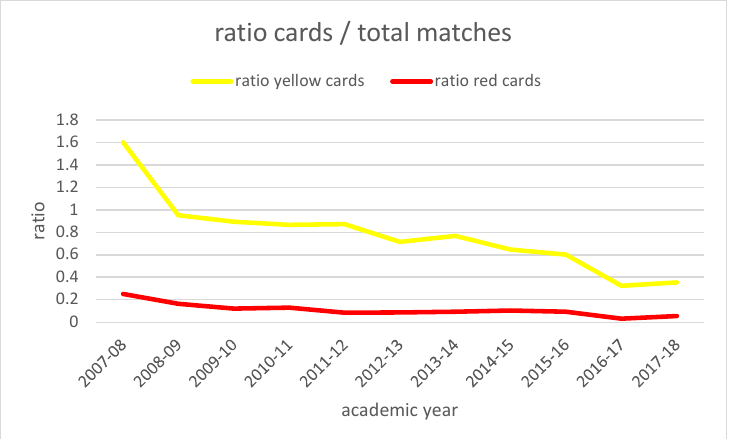
Figure 2. evolution of ratio of yellow cards and ratio of red cards through the academic years. Source: Own elaboration.